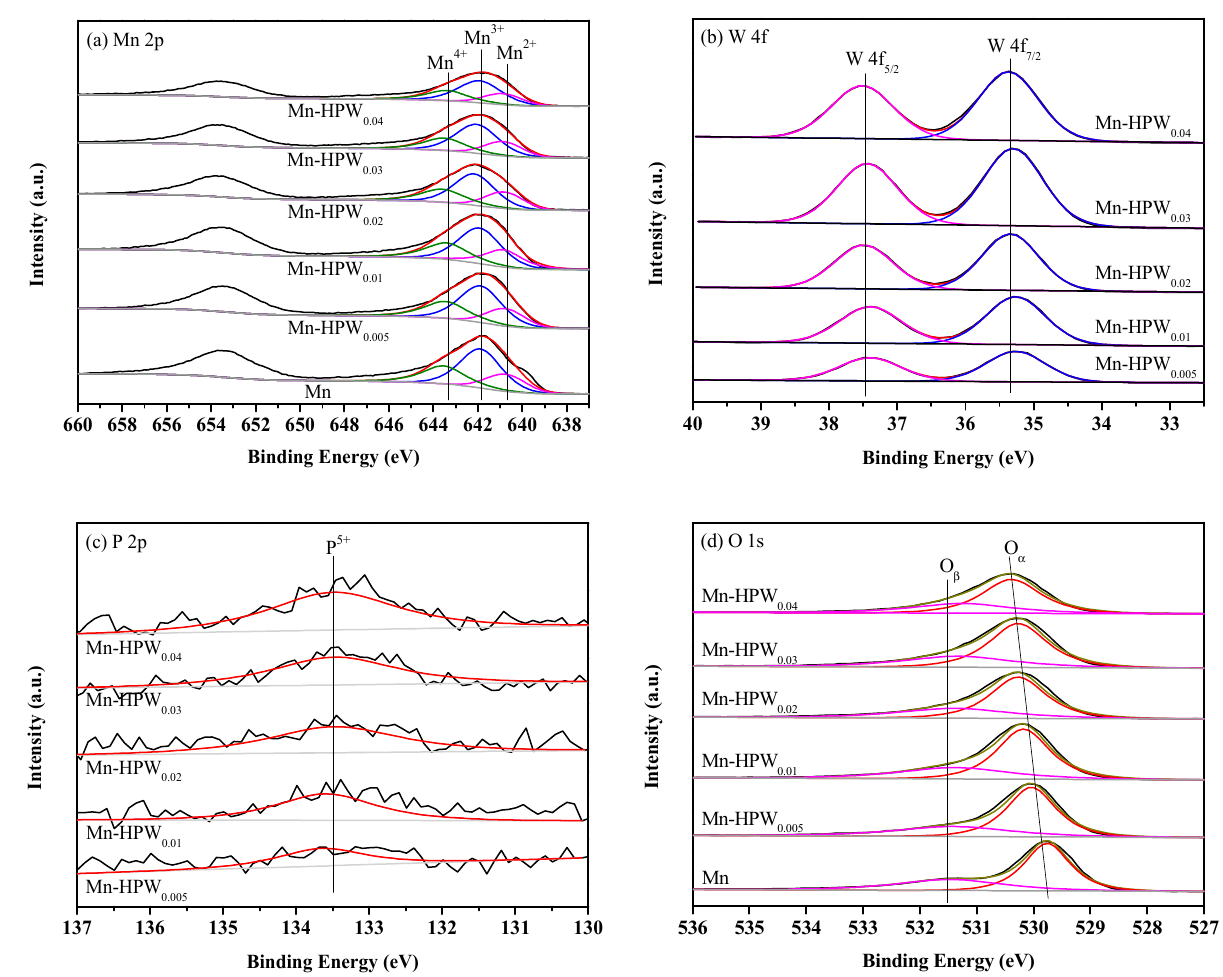
Figure 8. XPS results of Mn 2p ( a ), W 4f ( b ), P 2p ( c ), and O 1s ( d ) over Mn and Mn-HPW x